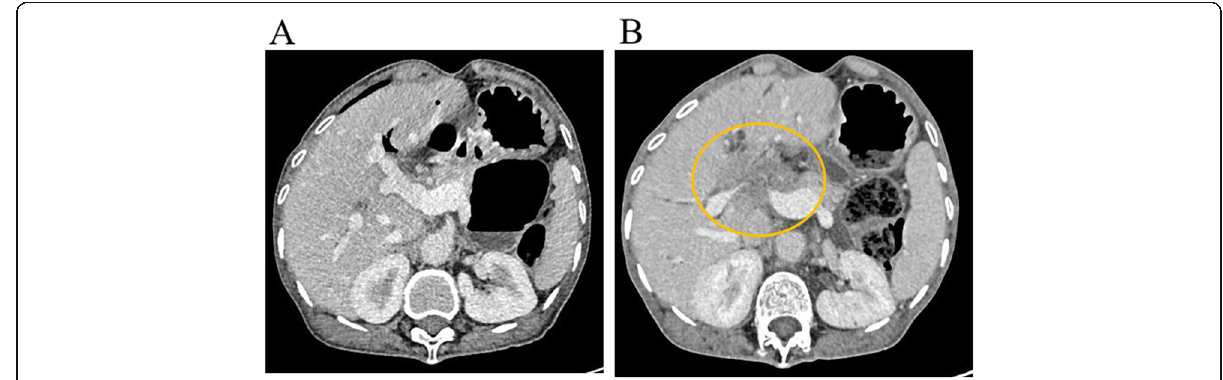
Fig. 3 a Computed tomography was performed at a regular checkup. The scan shows no gallstones or tumor formation in the liver at 62 years and 10 months of age. b A liver tumor at the porta hepatis is revealed by computed tomography. The patient was aged 63 years and 6 months. Yellow circle: the tumor at the porta